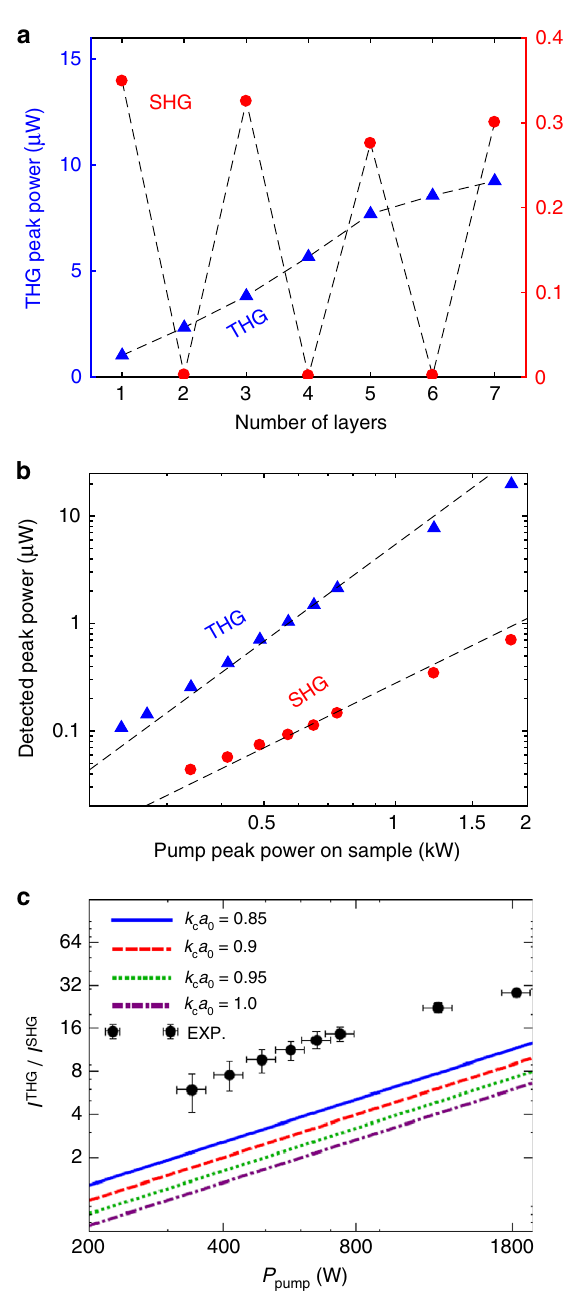
Fig. 4 Experimental and theoretical nonlinear optical processes in MoS 2 . a SHG and THG intensities as functions of N. b Power dependence of SHG and THG in 1L-MoS 2 . c Experimental and theoretical THG/SHG irradiance ratio as a function of P pump . Different theoretical curves refer to different values of the ultra-violet cutoff k c (in units of 1 = a 0 ¼ a = 3.16 Å is the lattice constant of 1L-MoS a and b are a guide to the eye. The error bars in c account for